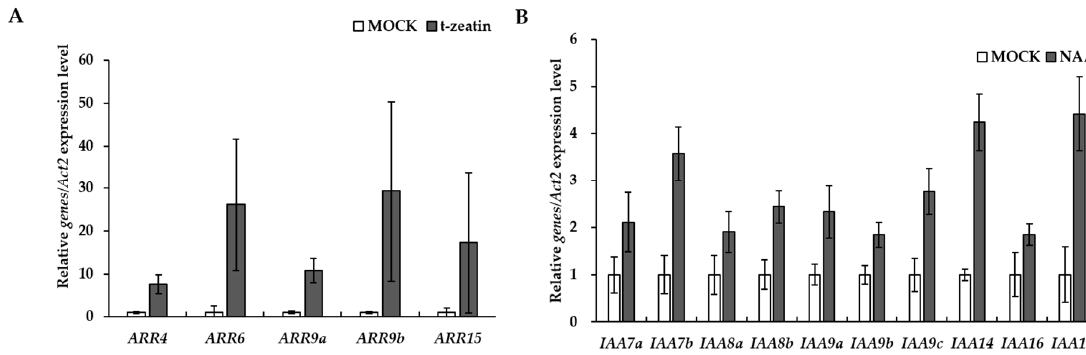
Figure 5. Negative feedback loops in auxin and cytokinin signaling responses in P. ginseng seedlings. Relative gene expression levels of type-A response regulators ( A ) and AUX/IAAs ( B ) in three-month-old P. ginseng seedlings treated with cytokinin and auxin, respectively, were quantified by a real time qRT-PCR ( n = 4, Error bars indicate ± standard error).